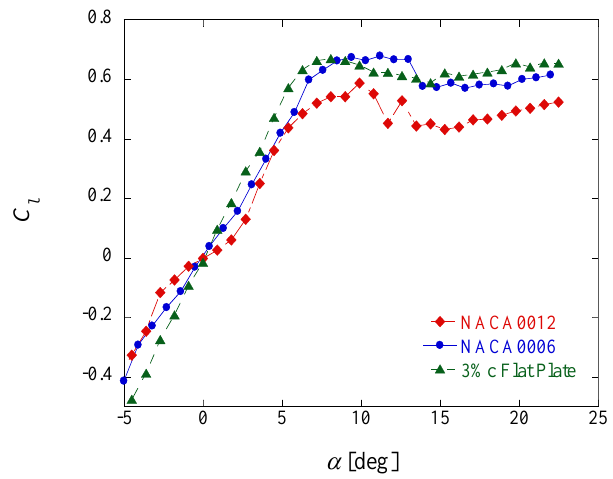
Fig. 5 Comparison of lift curves at Re = 20,000. Each lift curve is indicated by red diamond-NACA0012, blue circle-NACA0006, and green triangle-3% c flat plate. The lift curve of 3% c flat plate exhibits high linearity and the highest lift-curve slope. By contrast, the non-linearity in the lift curve and lower lift coefficients are observed for NACA0012